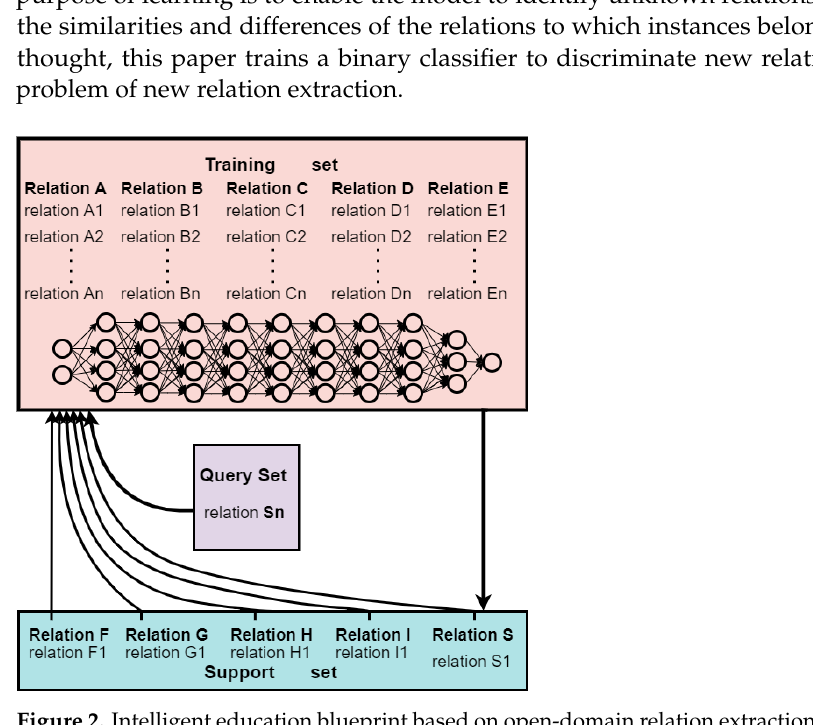
Figure 2. Intelligent education blueprint based on open-domain relation extraction and AI